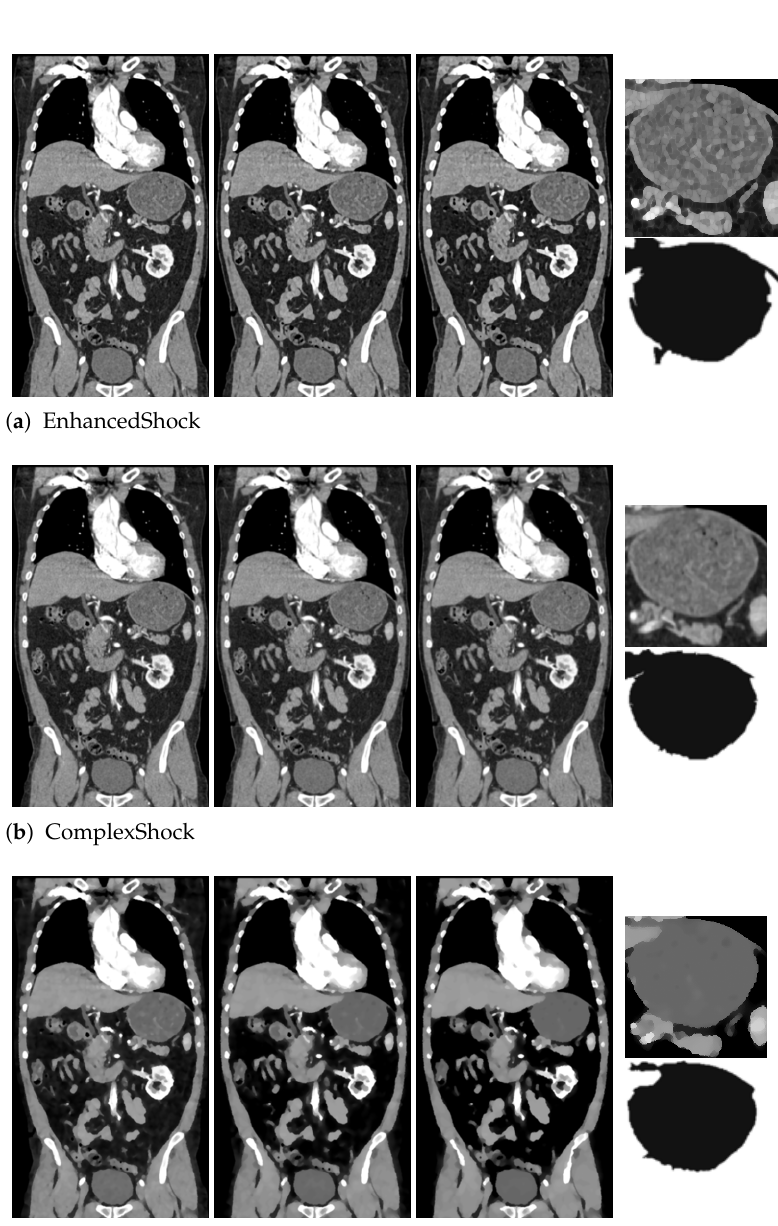
Figure 9. Segmentation obtained from one CT slice, with different methods, after 10, 20, and 30 iterations. A part of the segmentation is also presented.